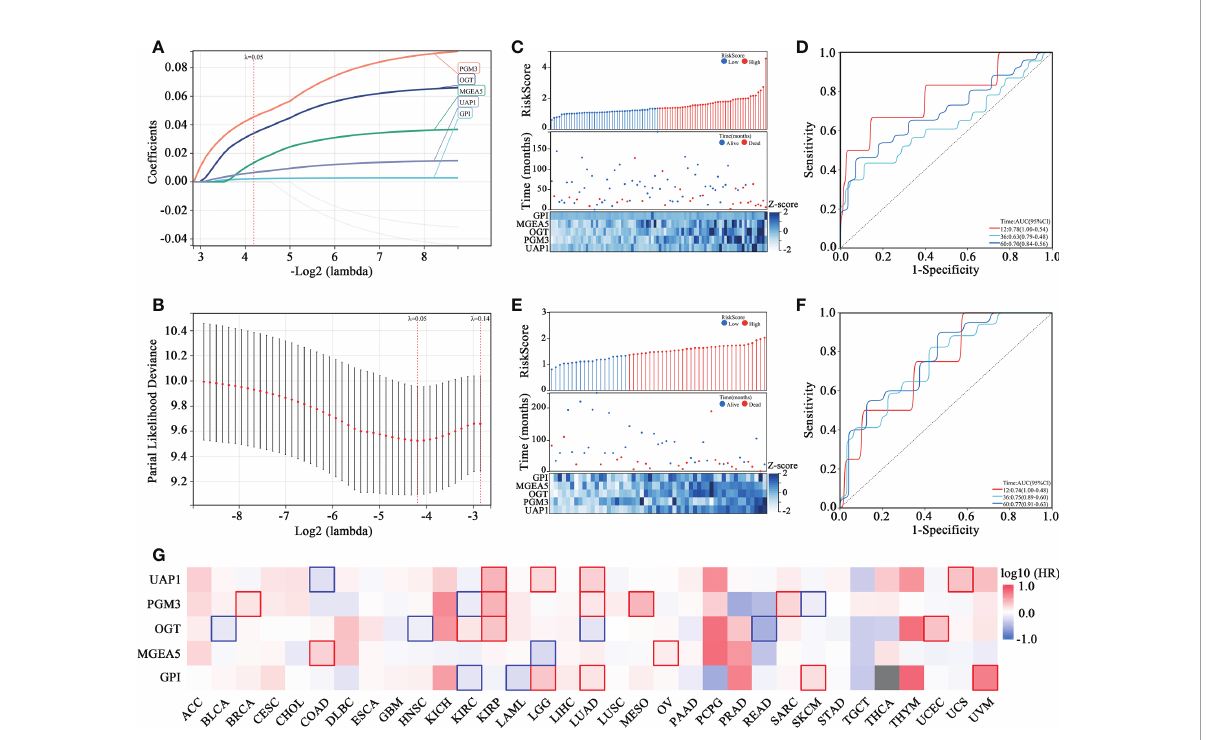
FIGURE 2 Identi fi cation of HBP-related 5 genes with prognostic value in OS patients. (A, B) The adaptive LASSO Cox regression for the prognostic value of HBP-related genes. (C – F) The risk score distribution, survival status, heatmap and time-dependent ROC curve of HBP-related gene signature in Target-OS (C, D) and GSE21257 (E, F) cohorts. (G) The survival heatmap of HBP-related genes across all tumor types from The Cancer Genome Atlas (TCGA). The red frame and blue frame represent statistical signi fi cance in Kaplan-Meier survival